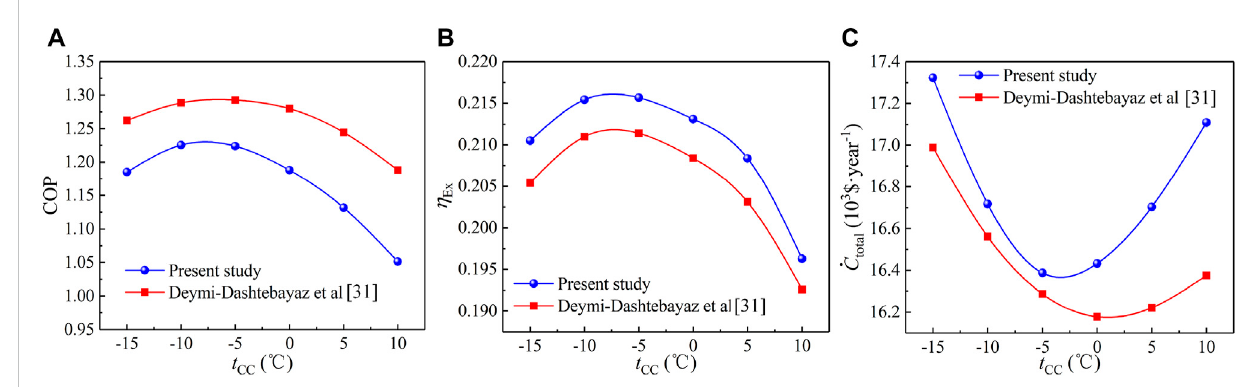
FIGURE 3 Comparison between modeling results in present study and computational results of Deymi